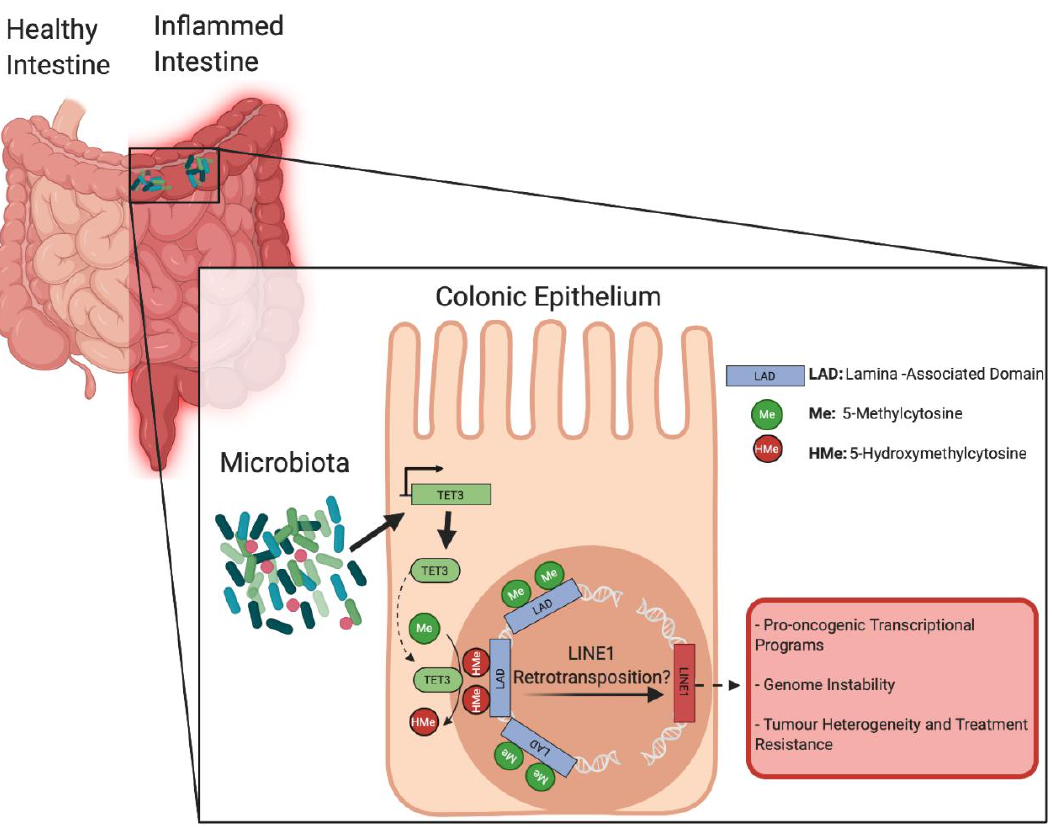
Figure 1. The intestinal microbiota influences DNA methylome and susceptibility to colorectal cancer (CRC). Relationship between the intestinal microbiota and active demethylation machinery in the context of bowel inflammation. Microbiota-induced Ten-Eleven-Translocation 3 (TET3) expression is reorganizing the epigenetic landscape of lamina-associated domains (LADs) in colonocytes, leading to transcriptional changes characteristic of CRC. Image created with BioRender.com.